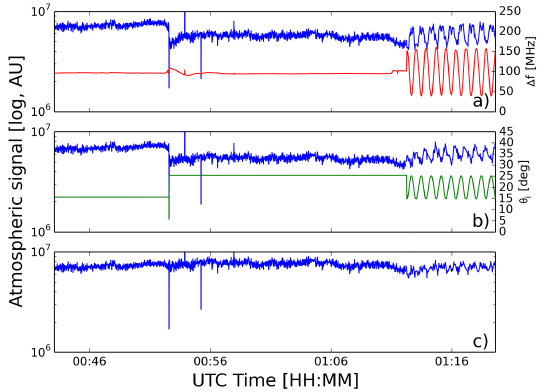
Figure 7. Estimated system response k θ (red line) as a function of the angle of incidence θ i of the laser beam on the aircraft window. The normalized backscatter data points (blue dots) are the averaged measured backscatter power at altitudes between 2 and 3km for several vertical profiles and different angles of incidence during the flight on 26 June. The mean values for the normalized backscatter (red crosses) are derived from measurements with similar angle of